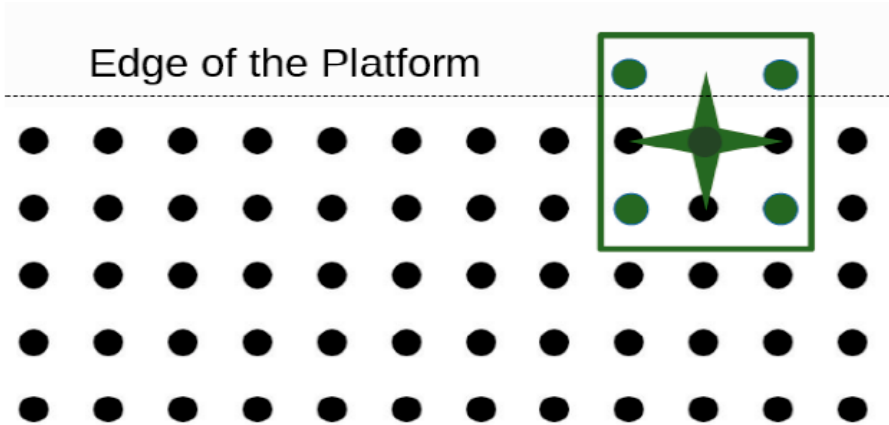
Figure 12. Non-feasible configuration when the electrodes at the edge of the platform are not rejected from the micro-graph.